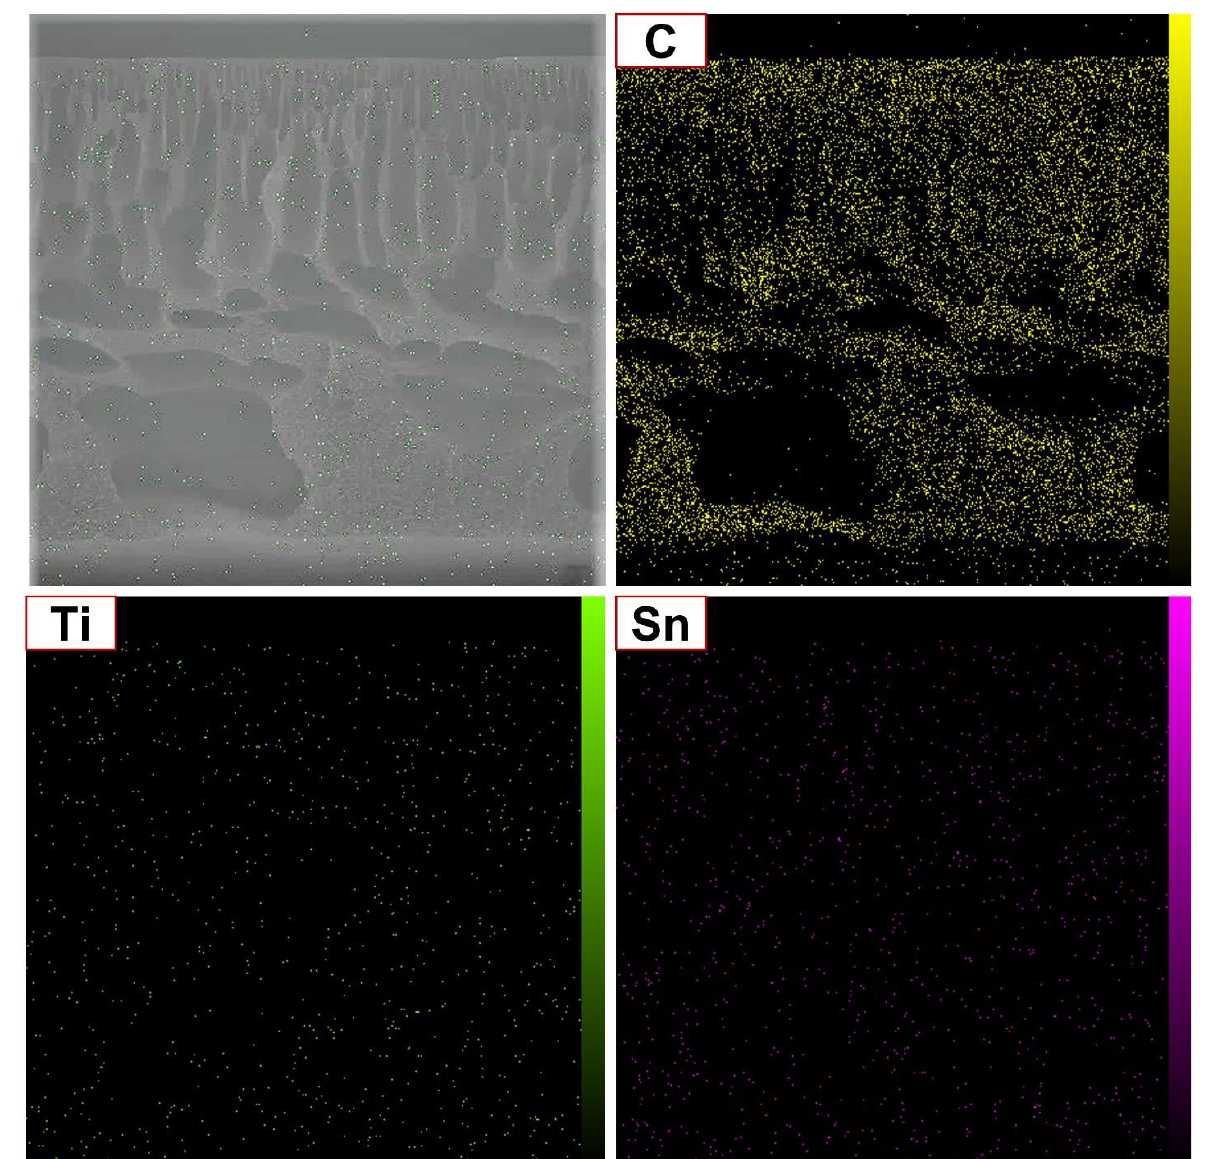
Figure 3. EDAX dot mapping analysis of M3 membrane sample.